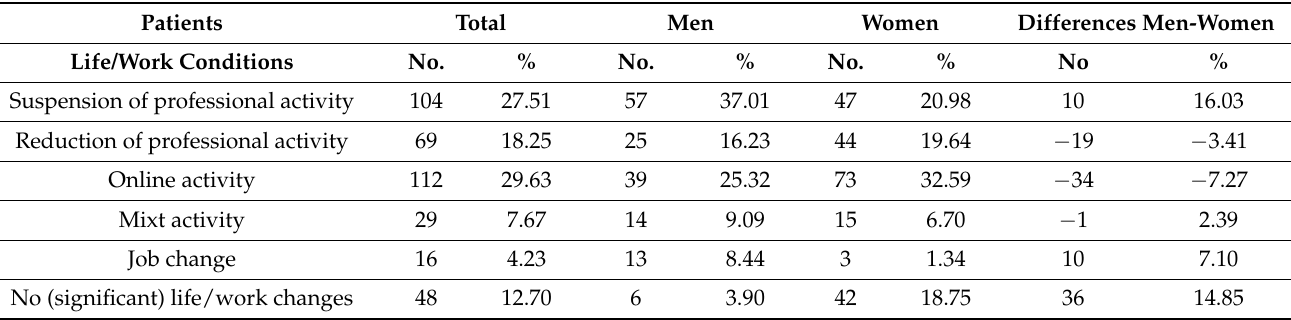
Table 3. Changes in patients’ life/work